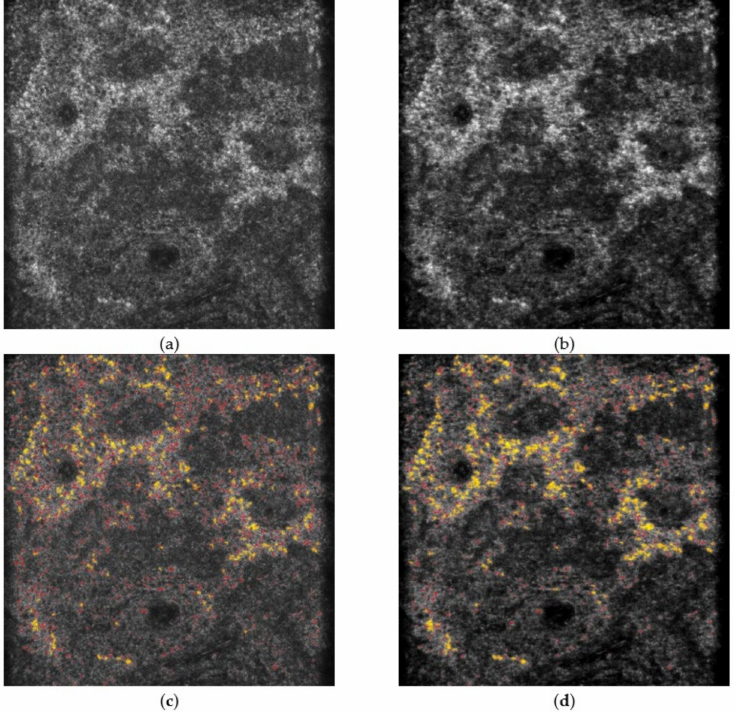
Figure 6. The performance comparison of CADe with and without SC-DnCNN on the representative lesion images. ( a , b ) are the input image and the denoised image, respectively, while ( c , d ) are the output results when superimposing the detected melanin on those images (grain melanin is represented in red, and confetti melanin is represented in yellow), respectively. The field of view is 475 × 476 µ